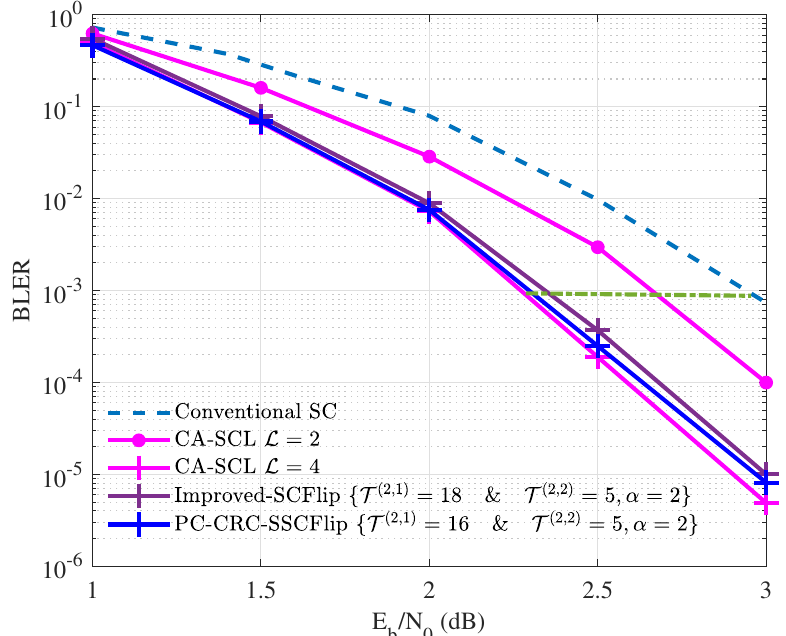
Figure 8. BLER performance comparison of the PC-CRC-SSCFlip decoder with SCFlip, improved- SCFlip, and CA-SCL decoders for P ( 1024,512 ) with 24 check